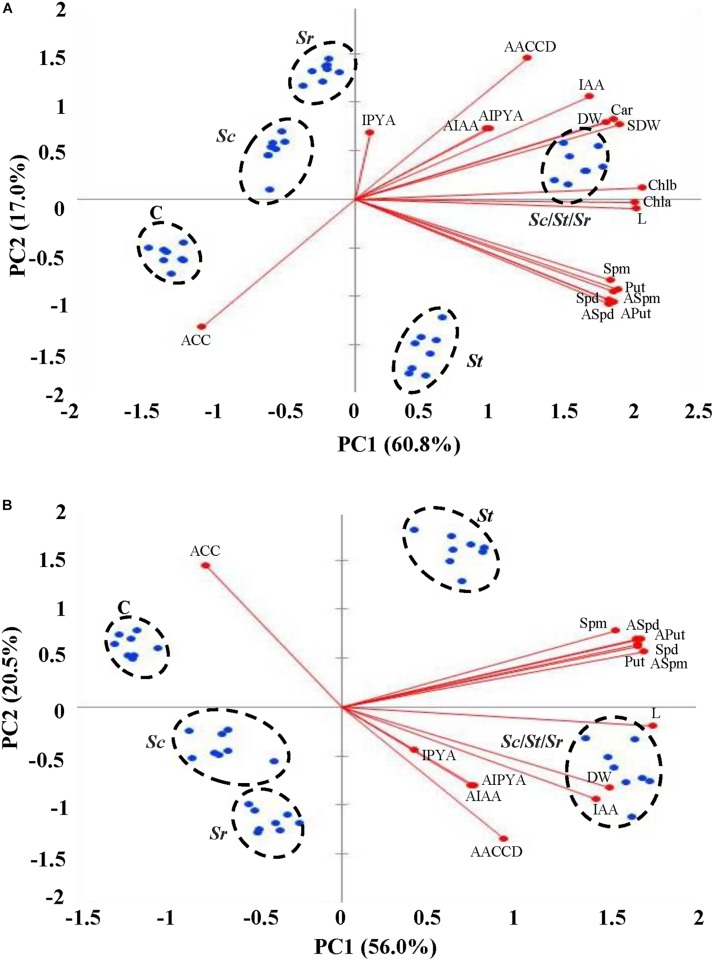
Multivariate statistical analyses of the endogenous PGRs of Salicornia bigelovii treated with actinobacterial isolates. Principal component (PC) analysis on (A) shoot and (B) root tissues of S. bigelovii after treatment with autoclaved non-inoculated oat bran (control); auxin-producing isolate #21 (S. chartreusis UAE1, Sc); PA-producing isolate #7 (S. tritolerans RAK1, St); ACCD-producing isolate #11 (S. rochei RAMS1, Sr) consortium of the three rhizosphere-competent isolates (Sc/St/Sr). Two auxins (AIAA and AIPYA), three PA (Aput, ASpd, and Aspm) and (AACCD) obtained from actinobacterial isolates, eight agronomic growth parameters (L and DW in shoot and root separately, chl a, chl b, and Car in shoot, and SDW) and six plant growth regulators (IAA, IPYA, Put, Spd, Spm, and ACC) obtained from S. bigelovii, were tested. S. bigelovii seedlings were grown in an evaporative-cooled greenhouse and maintained at 25 ± 2°C. Values are means of eight replicates for each sampling from two independent experiments. IAA, indole-3-acetic acid; IPYA, indole-3-pyruvic acid; Put, putrescine; Spd, spermidine, Spm, spermine; ACC, 1-aminocyclopropane-1-carboxylic; PA, polyamines; ACCD, ACC deaminase; L, length; DW, dry weight; Chl, chlorophyll; Car, carotenoids; SDW, seed dry weight.